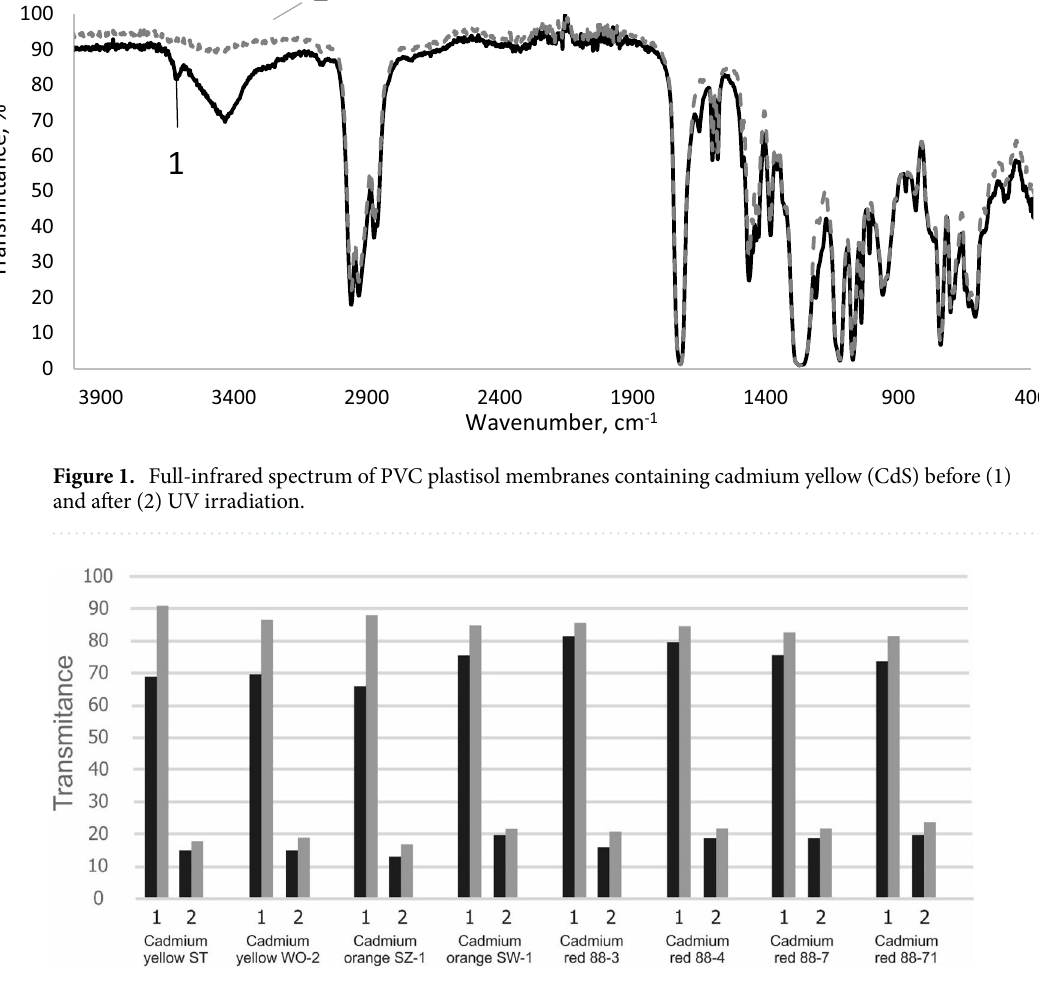
Figure 2. Transmittance values of PVC films containing pigments before and after UV irradiation Explanations: 1,2—wave number ranges given in Table